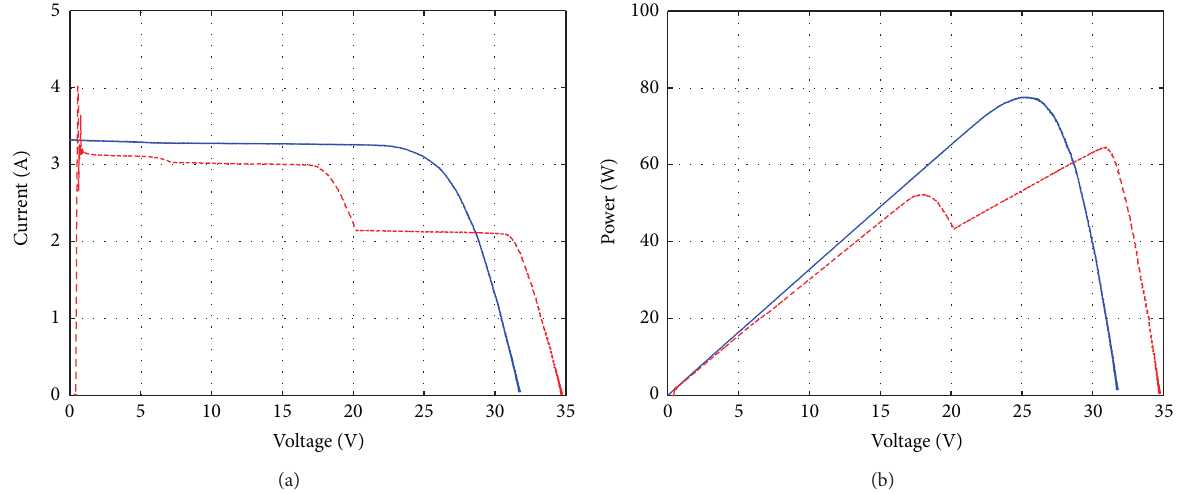
Figure 11: Measured (a) I-U and (b) P-U characteristics of the PV module equipped with irradiance and temperature sensor S19 under homogeneous irradiance on August 31st, 2011, at 12:04 (blue lines) and under partial shading conditions on February 3rd, 2012, at 11:19 (red- dashed lines).